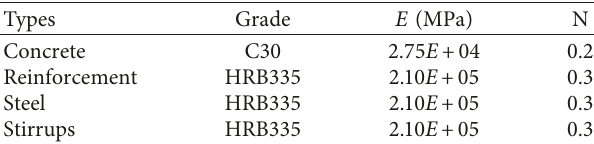
Table 4: Material properties of the concrete and steel